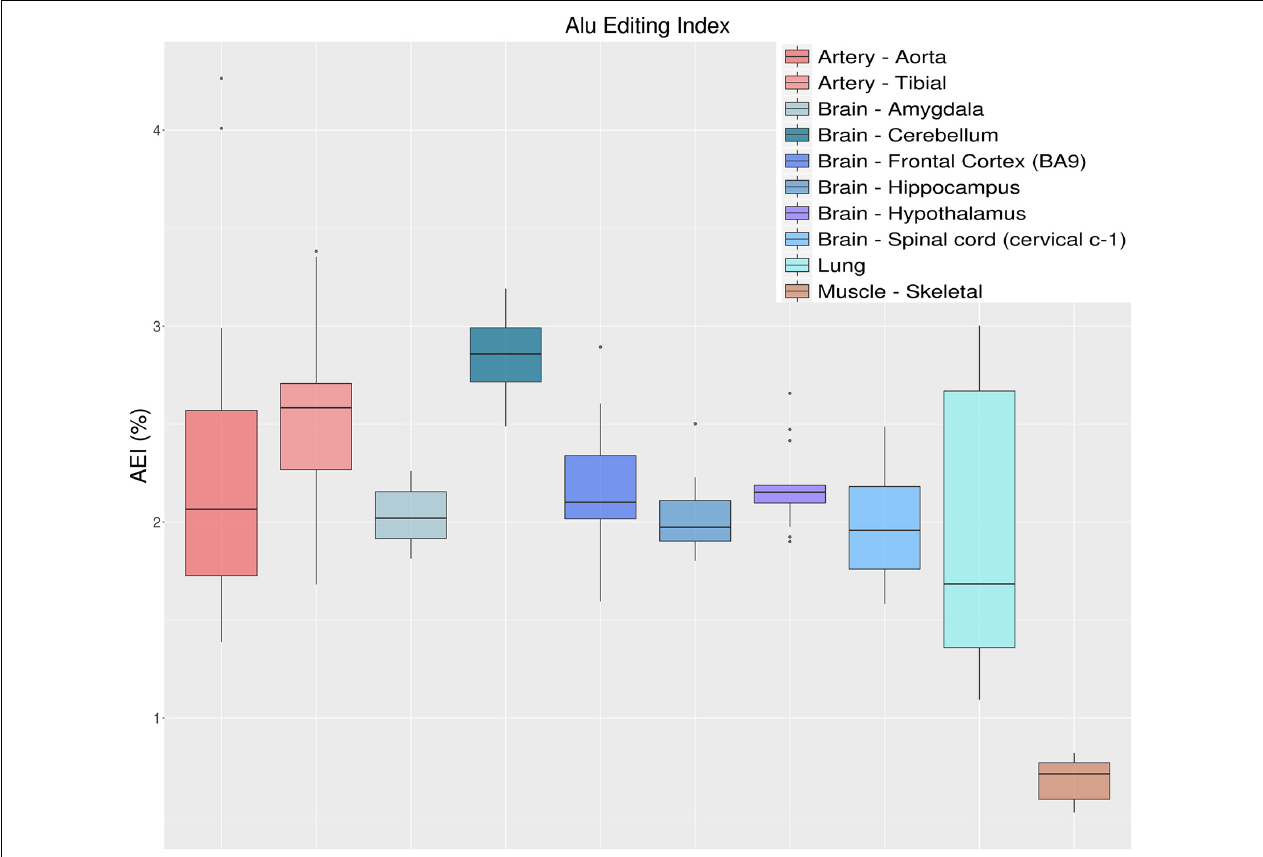
FIGURE 7 | Distributions of Alu editing index (AEI) values over 10 selected tissue types from the GTEx project. AEI represents the weighted average editing level across all expressed Alu sequences. Distributions are presented as box-plots. AEI clearly recapitulates the same trend as overall editing thus confirming that the sites in Alu regions are those that have the greatest impact on the global editing